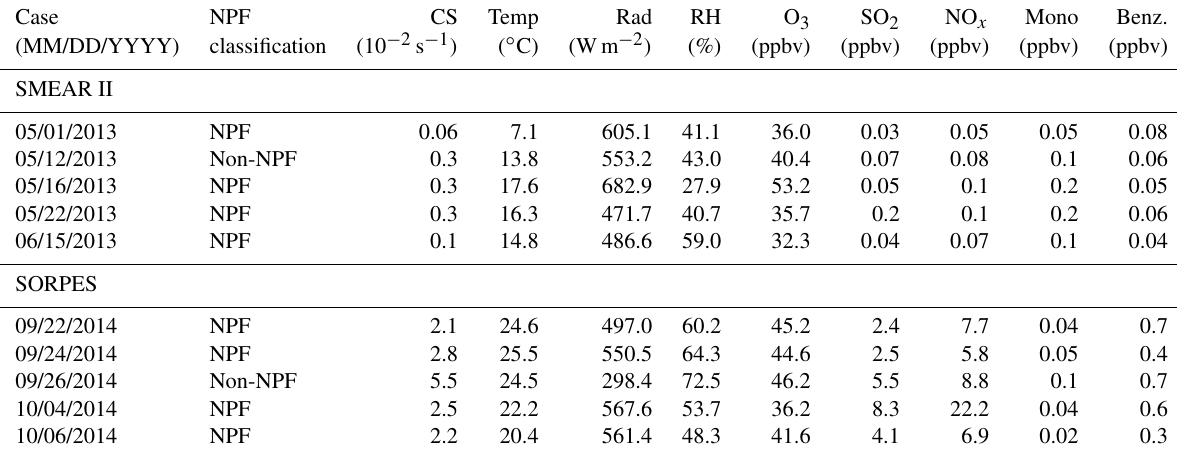
Table 2. The NPF classification and environmental conditions on each chosen case day at SMEAR II and SORPES. Note that condensation sink, meteorological conditions, and the concentrations of trace gases are from 09:00 to 15:00LT.